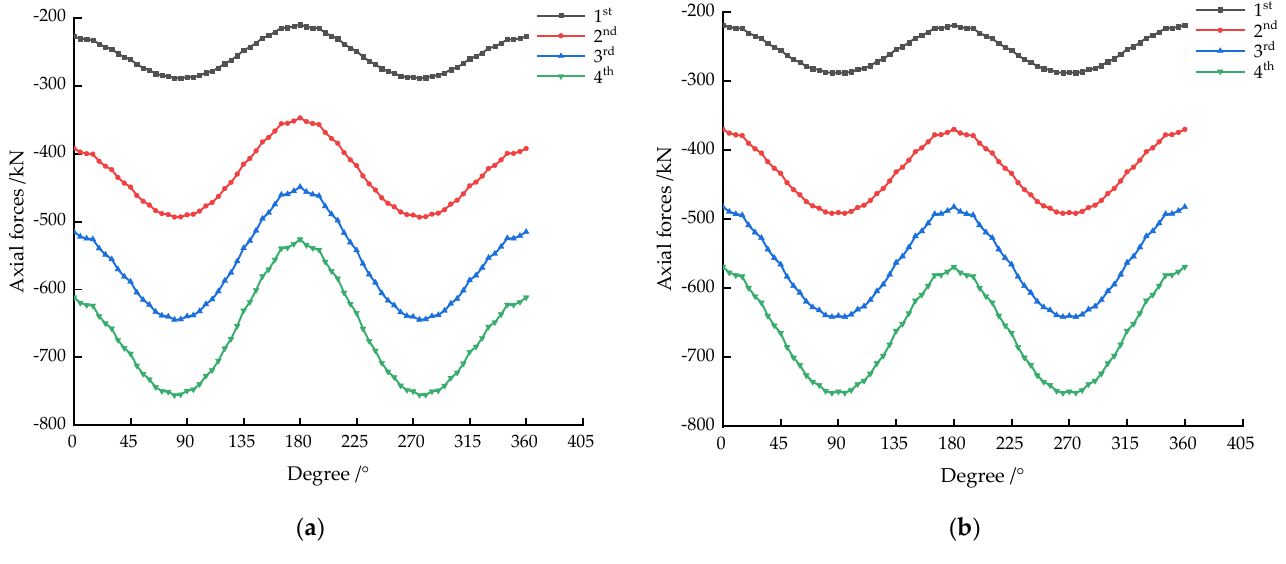
Figure 6. Simulated axial forces under different loading conditions (unit: kN): ( a ) Beam-spring model; ( b ) modified uniform rigidity ring model. Table 7. Simulated deformations under different loading conditions (unit: mm). Table 8. Simulated bending moments under different loading conditions (unit: kN ·